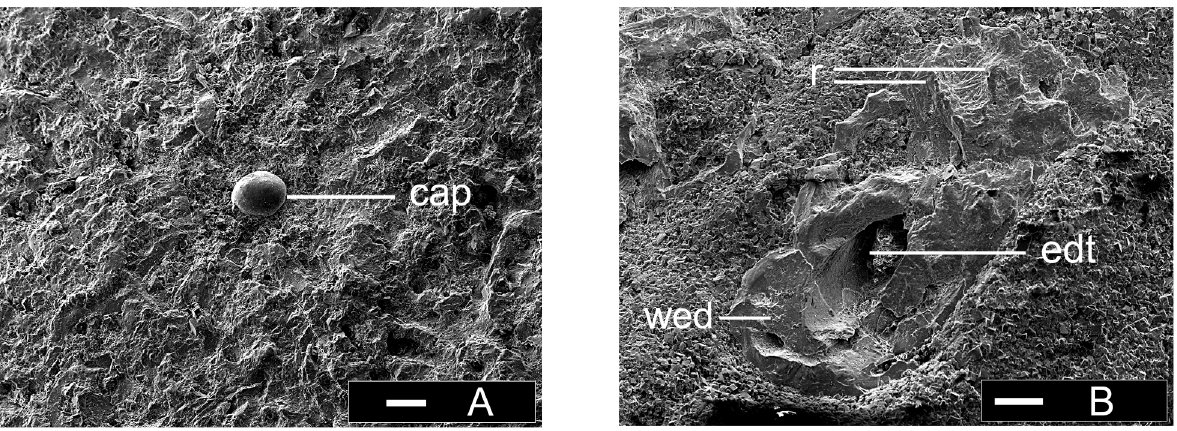
Fig. 7. Tremataspis mammillata Patten. Exposed middle layer of the shield. A , weakly expressed radial structure with a cap rising higher, TUG 1025-831; B , as a result of the breakage of the shield surface layer, the endolymphatic structure with a duct tube, thick wall and ridges on it are exposed. Locations : A, TUG 1025-831; B, TUG 1025-358-1, Himmiste Quarry; Himmiste Beds of the Paadla Regional Stage, Gorstian, Lower Ludlow. Scale bar = 100 µm (A, B). Abbreviations : cap, very small cap-like plate; edt, endolymphatic duct tube; wed, wall of endolymphatic duct; r, ridges related to the